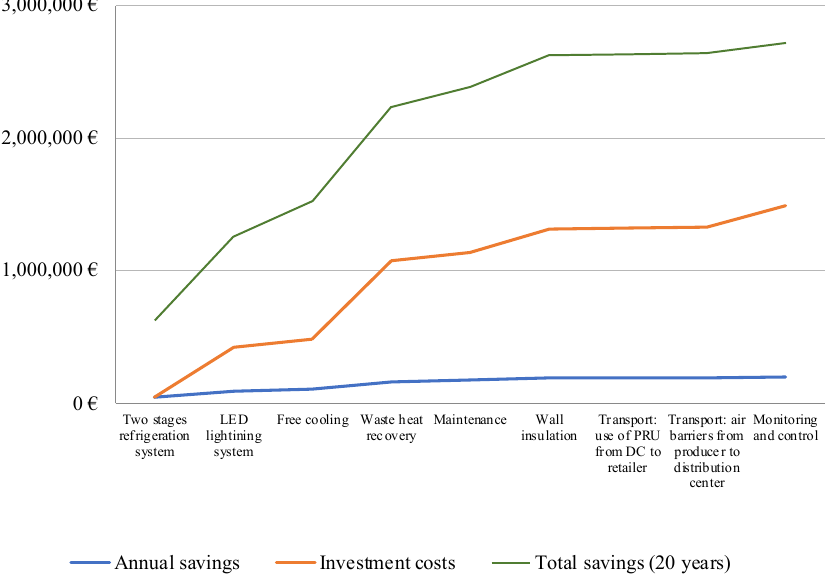
Figure 5. Economic impacts of the EEMs implementation in terms of cumulative annual and total savings over a period of 20 years, and investment costs.